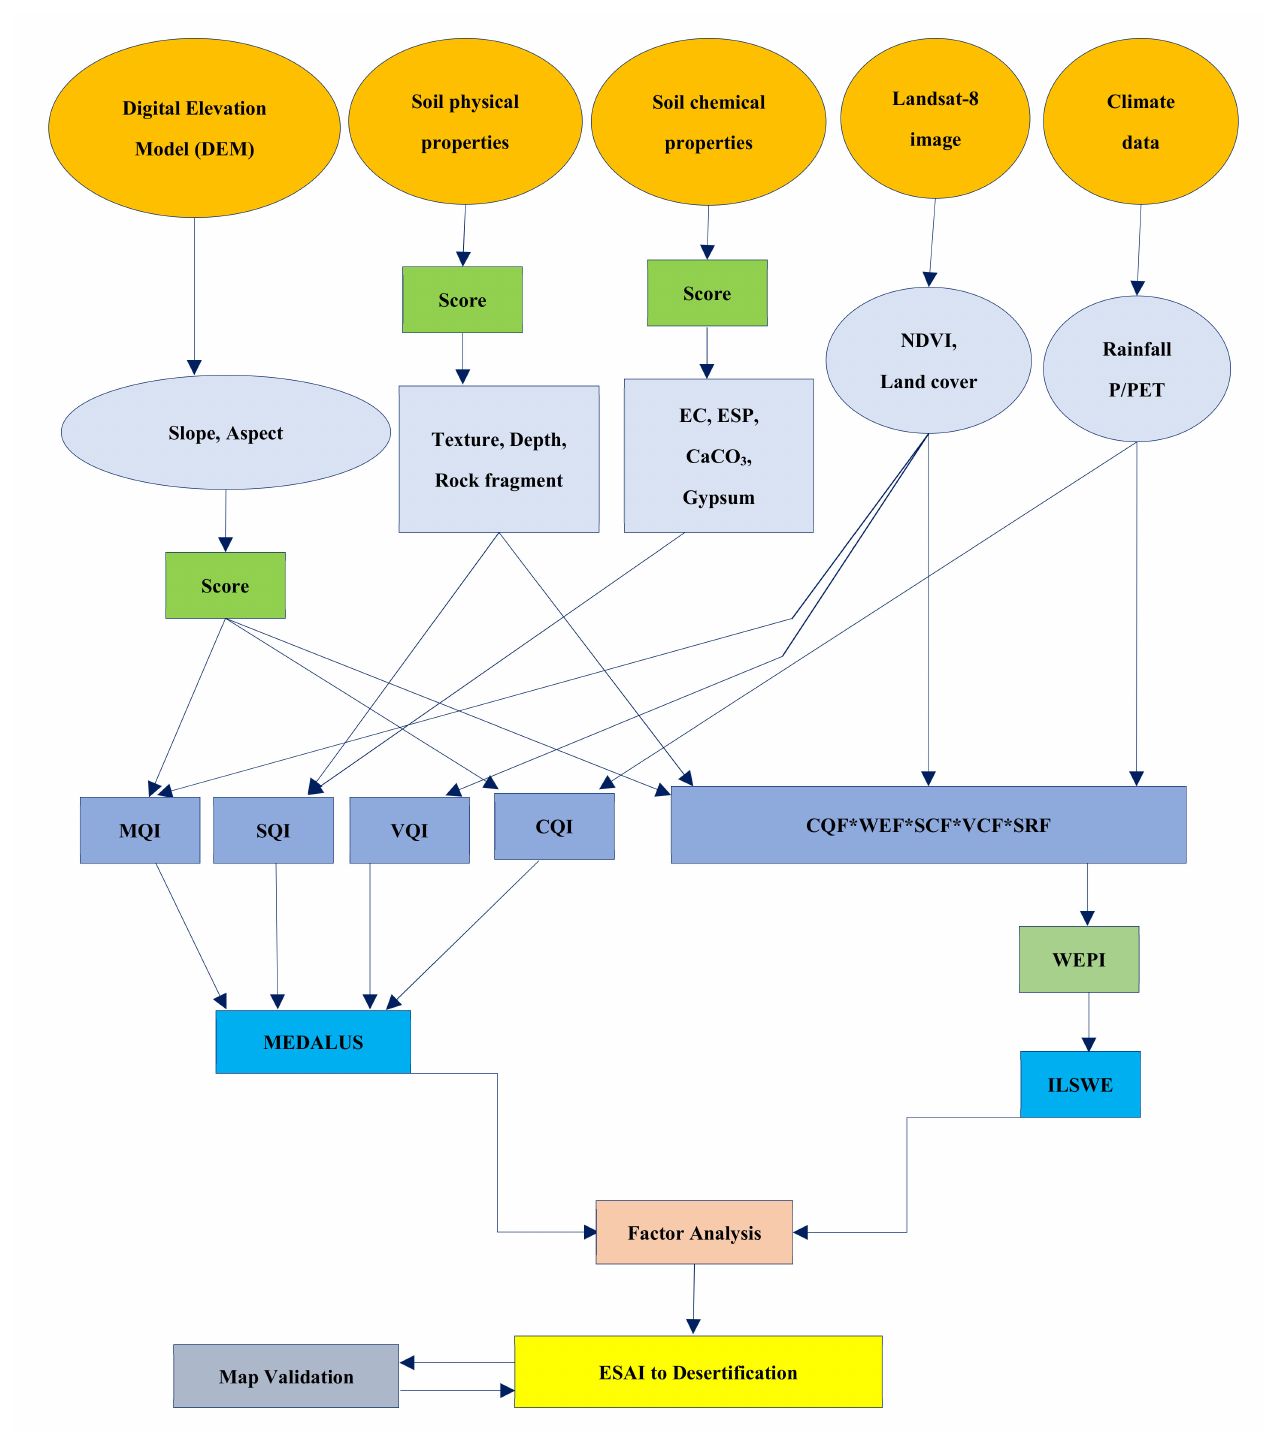
Figure 3. Methodology flowchart in the current